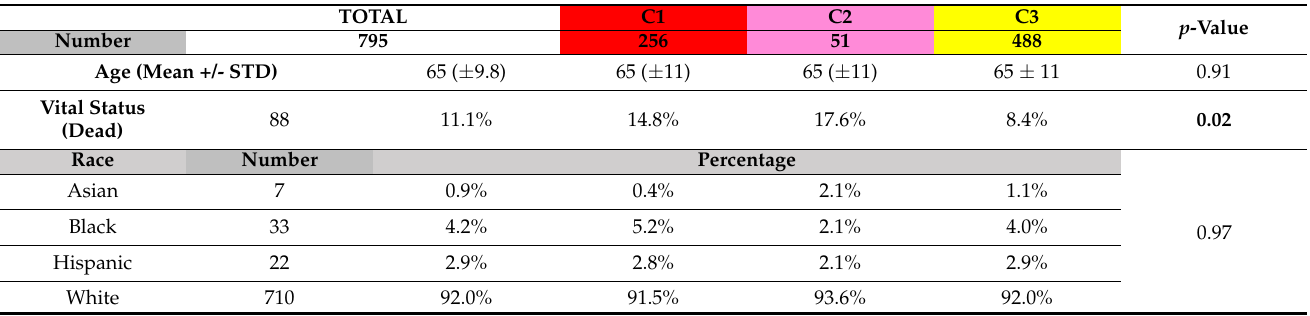
Table 1. DNA Damage Group Demographics and Clinical Information. A list of clinical characteristics is displayed in the first column, followed by numeric/categorical calculations for all CLL patients (column 2) and DNA damage patient groups (columns 3–5). In columns 2–5, the mean and standard deviations are displayed for numeric traits and percentages are displayed for categorical traits. Calculations were made based on information available in the dataset for each trait. p -values are displayed in the last column from chi-square (categorical) and Kruskal–Wallis tests (numeric) for the groups. Significant associations are in